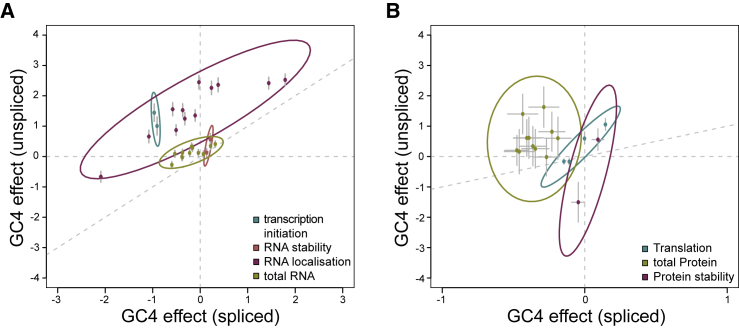
Splicing-Dependent Codon Usage Shapes Global Gene ExpressionEffects of GC4 content on the expression of unspliced (y axis) and spliced (x axis) endogenous human genes, on RNA level (A) and protein level (B). Each point corresponds to the regression coefficient of an individual experiment (cell line and/or biological replicate). Error bars indicate the standard error of these regression coefficients. Surrounding ellipses indicate the 95% confidence interval for 1,000 bootstraps of underlying data (see STAR Methods; Figure S6; Table S1). The diagonal indicates x = y.See also Figure S6; Table S1.